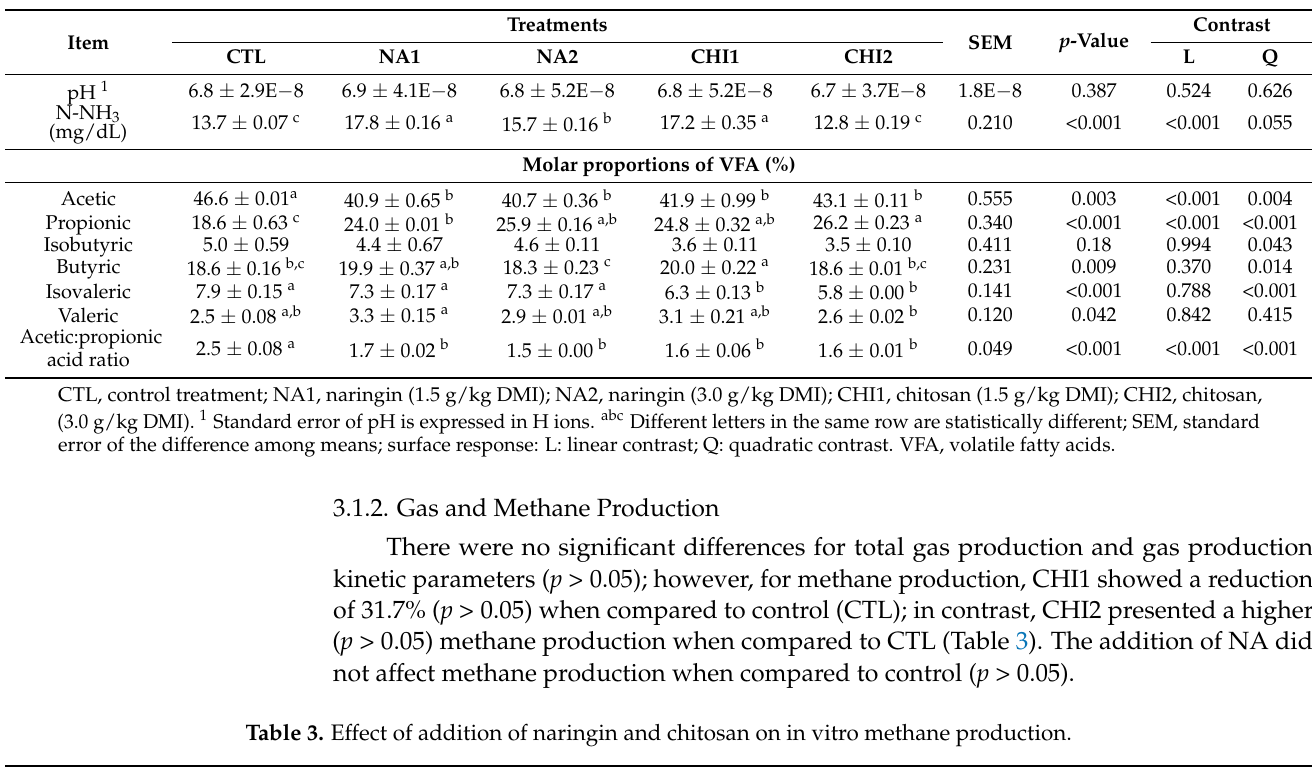
Table 2. In vitro ruminal fermentation patterns.